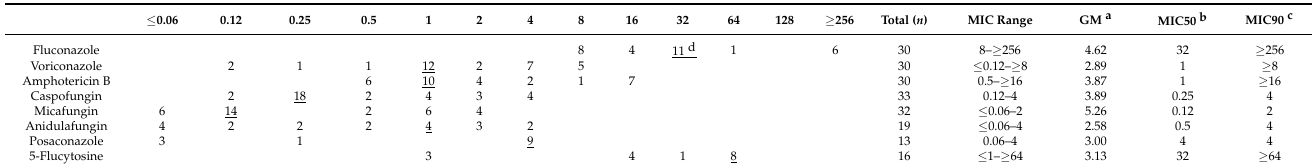
Table 1. MIC distribution of C. auris